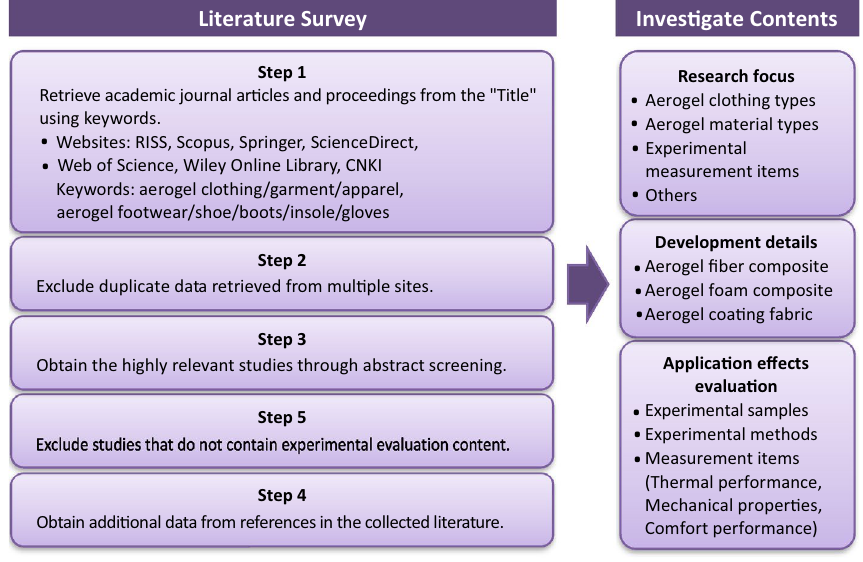
Fig. 1 Illustration of the research